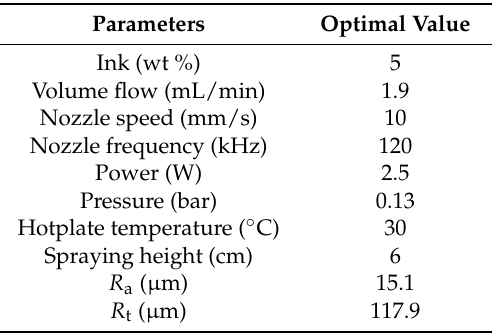
Table 1. Optimal parameters for the ultrasonic spray coating process whilst applying 10 layers of PVDF coating on SLS